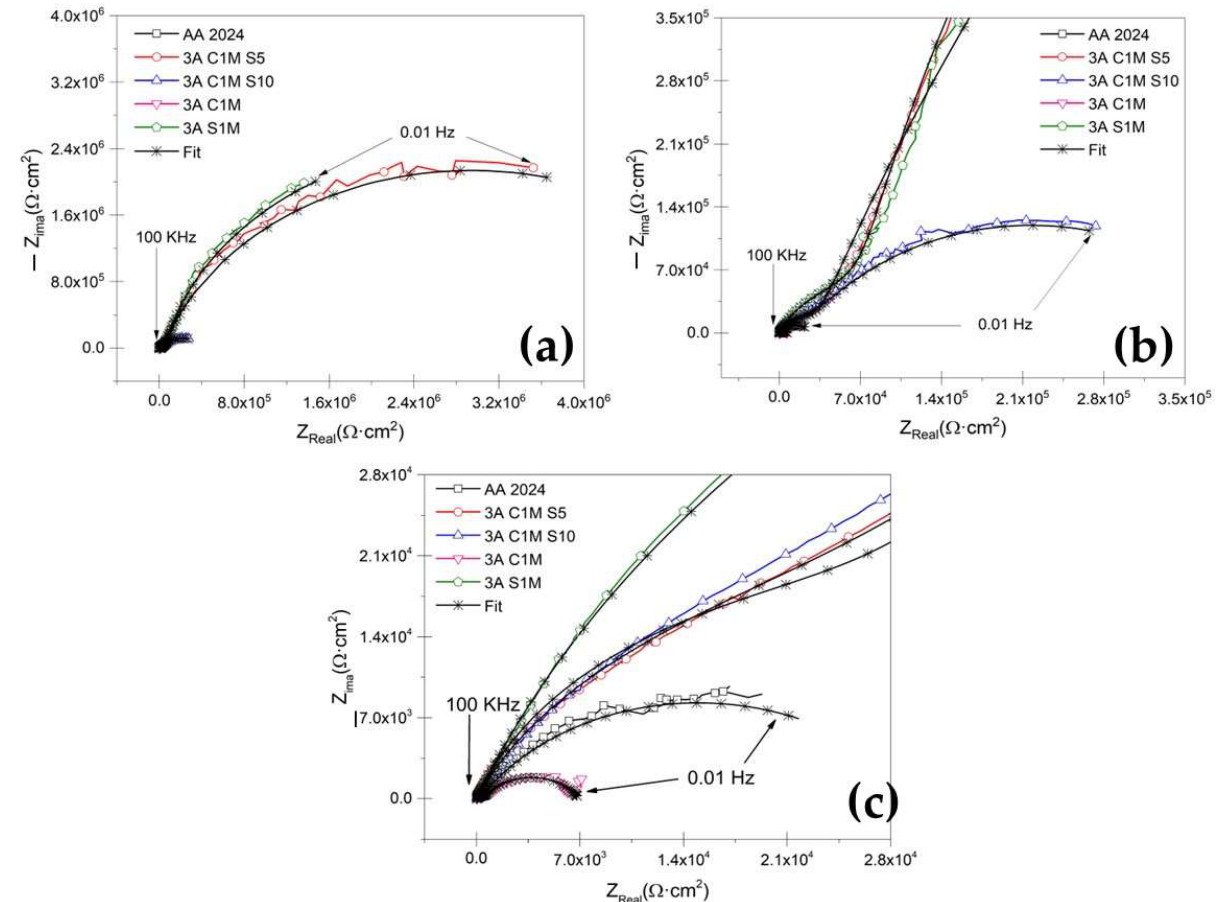
Figure 9. Nyquist plot for un-anodized AA2024 and citric–sulfuric acid-anodized samples immersed in NaCl solution. ( a ) i= 3 A/dm 2 , ( b ) first zoom of I = 3 A/dm 2 , and ( c ) second zoom of i = 3 A/dm 2 . Similarly, Figure 10a shows the Nyquist plot obtained for anodized samples in a mixture of citric–sulfuric acid and a current density of 4.5 A/dm 2 , exposed to the 3.5 wt. % NaCl electrolyte. In this case, the anodized samples with a current density of 4.5 A/dm 2 in all the solutions composed of citric–sulfuric acid present the characteristics of the porous layer in the high-frequency range, while in the low-frequency range they often exhibit barrier layer properties. The Nyquist plot (Figure 10) shows that the anodized samples in citric acid solutions have a lower corrosion rate than the non-anodized AA2024 aluminum alloy because they have depressed semicircles at high frequency (1 × 10 2 –1 × 10 4